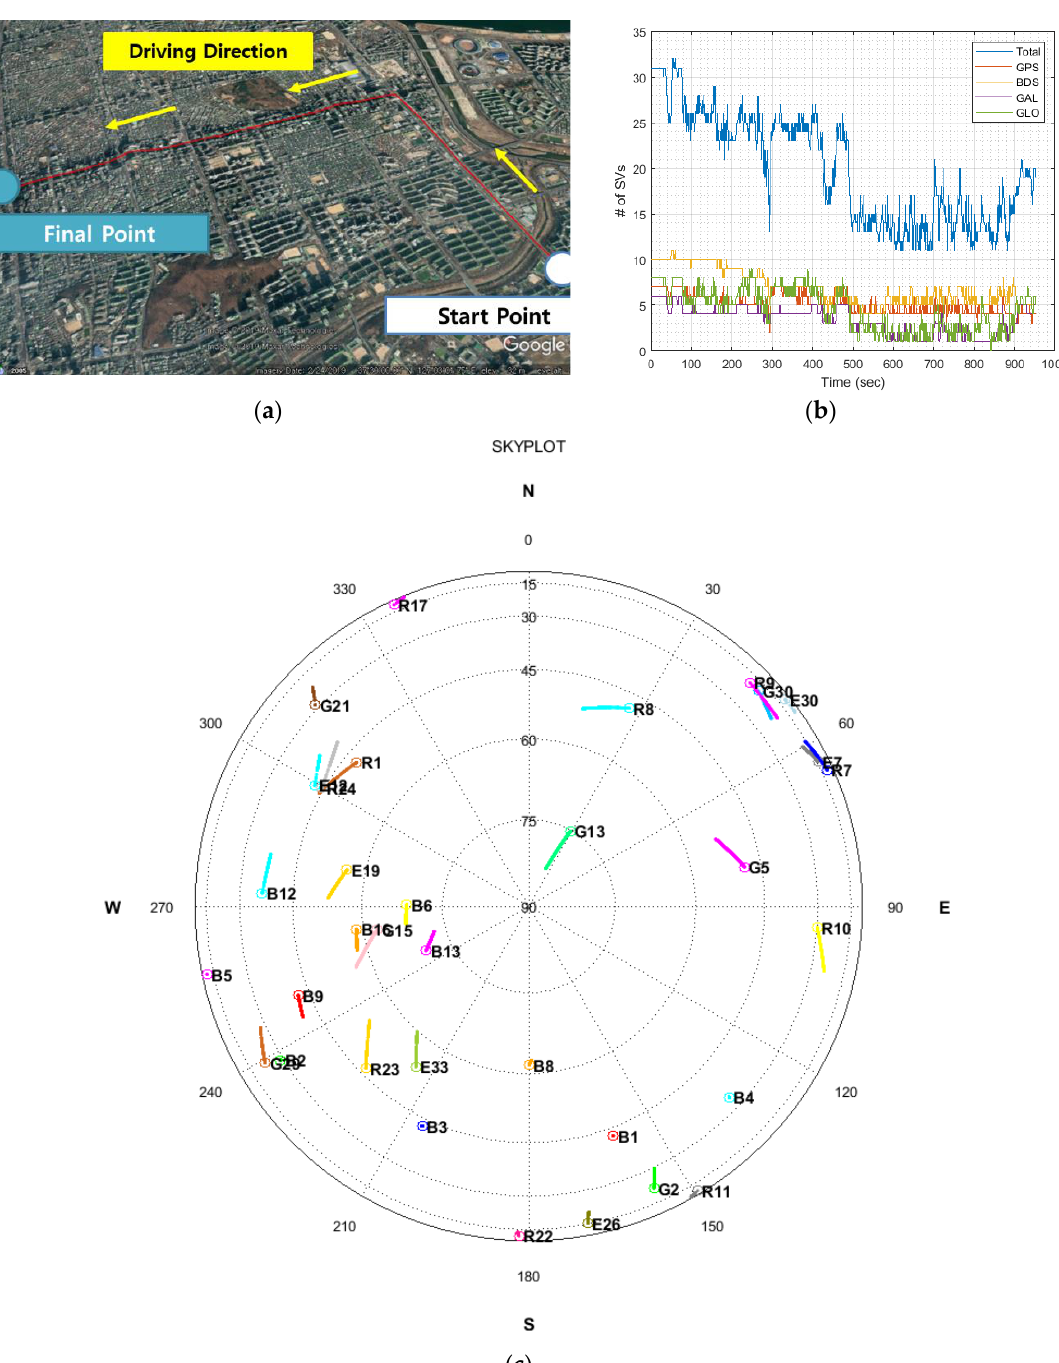
Figure 9. ( a ) Tracked trajectory; ( b ) number of visible satellites; ( c ) sky plot.